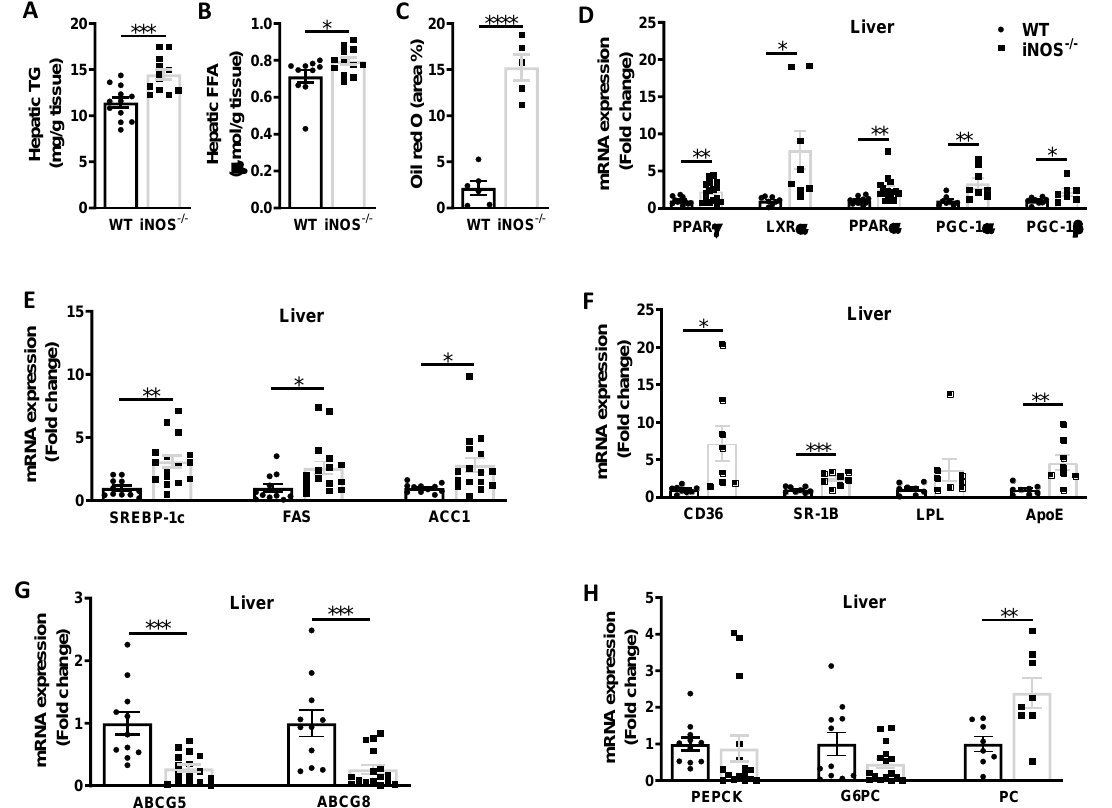
Figure 2. Metabolic homeostasis in liver of chow fed WT and iNOS − / − mice. Lipid accumulation in liver. ( A ) Hepatic triglycerides ( n = 12), ( B ) hepatic free fatty acids (WT: n = 10, iNOS − / − , n = 12) and ( C ) hepatic Oil red O staining (WT: n = 6, iNOS − / − , n = 5). ( D ) qPCR expressions of transcriptional regulators involved in lipid synthesis: PPARy (WT: n = 11, iNOS − / − , n = 16) and LXR α ( n = 8) and genes involved in fatty acids oxidation: PPAR α ( n = 11–16), PGC-1 α , and PGC-1 β ( n = 8). ( E ) qPCR expression of genes involved in lipid synthesis (WT: n = 11, iNOS − / − , n = 16): SREBP-1c, FAS, and ACC1. ( F ) qPCR expression of genes involved in lipid uptake ( n = 8): CD36, SR-B, ApoE, and LPL. ( G ) qPCR expression of genes involved in lipid e ffl ux (WT: n = 11, iNOS − / − , n = 16): ABCG5 and ABCG8. ( H ) qPCR expression of genes involved in gluconeogenesis (WT: n = 11, iNOS − / − , n = 16): PEPCK, G6PC, and PC ( n = 8) in chow fed WT and iNOS − / − mice. Data are represented as mean ± SEM. Black circles: WT, black squares: iNOS − / − mice. * p < 0.05, ** p < 0.01, *** p < 0.001, **** p < 0.0001 vs. WT.